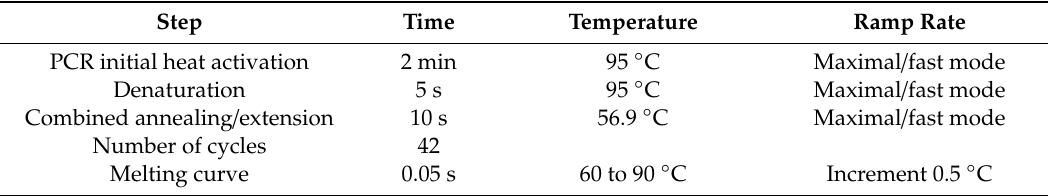
Table 2. Fluorescence quantitative PCR